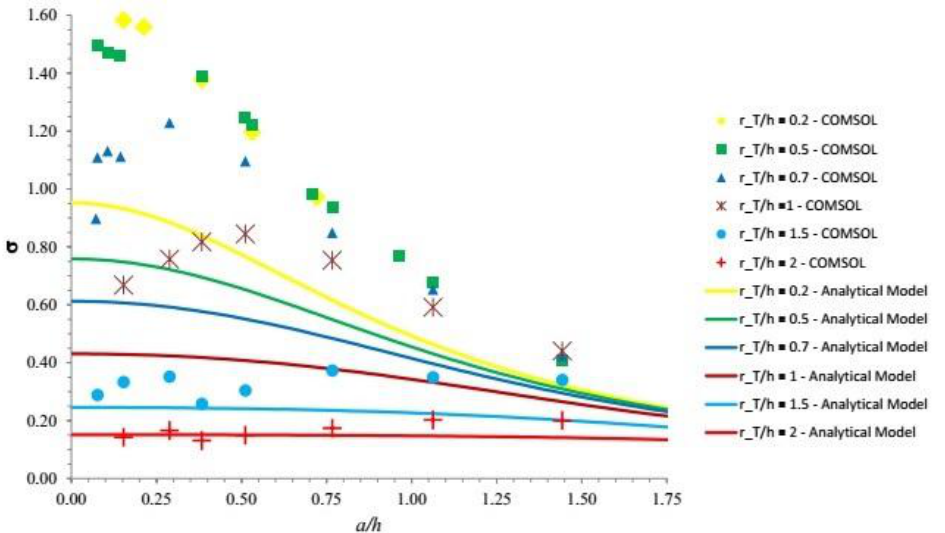
Figure 9. An example of FEM simulation results (total displacement is shown). Parameters: F 3 = 2 N, R = 10 mm, E = 16 MPa, ν = 0.5, r T = 1 mm. Elastomer size: thickness h = 2.5 mm, length l = 40 mm, width b = 20 mm.